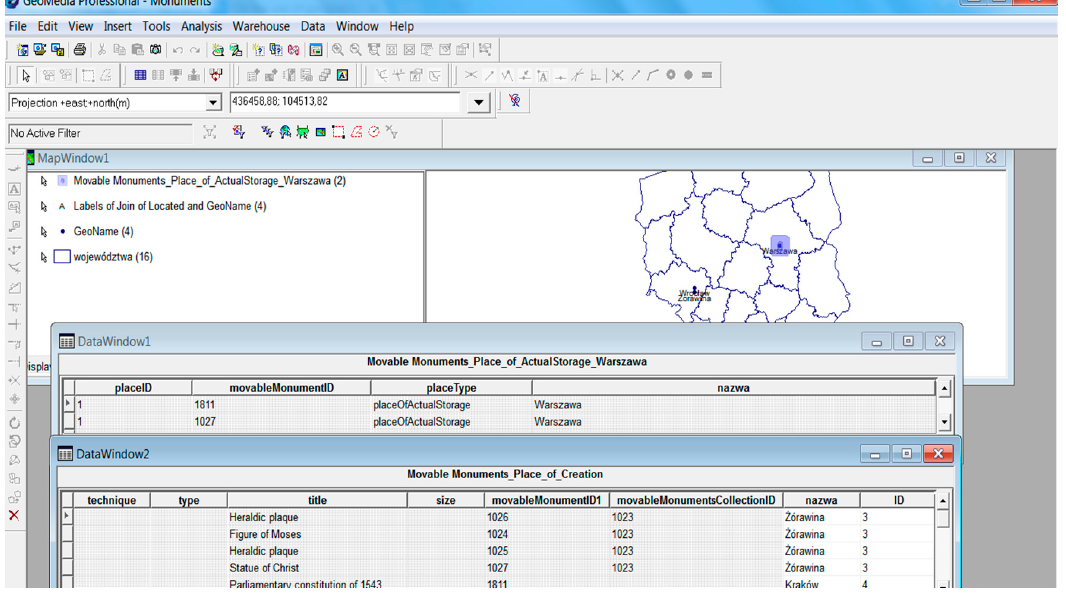
Figure 8. Presentation of results of monument selection in the table and on the map (source: own work).